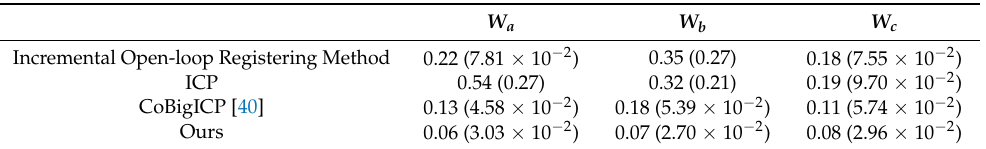
Table 2. Registration error (mm) and uncertainty (standard deviation, in brackets) of three objects W a , W b , W c compared with three registration